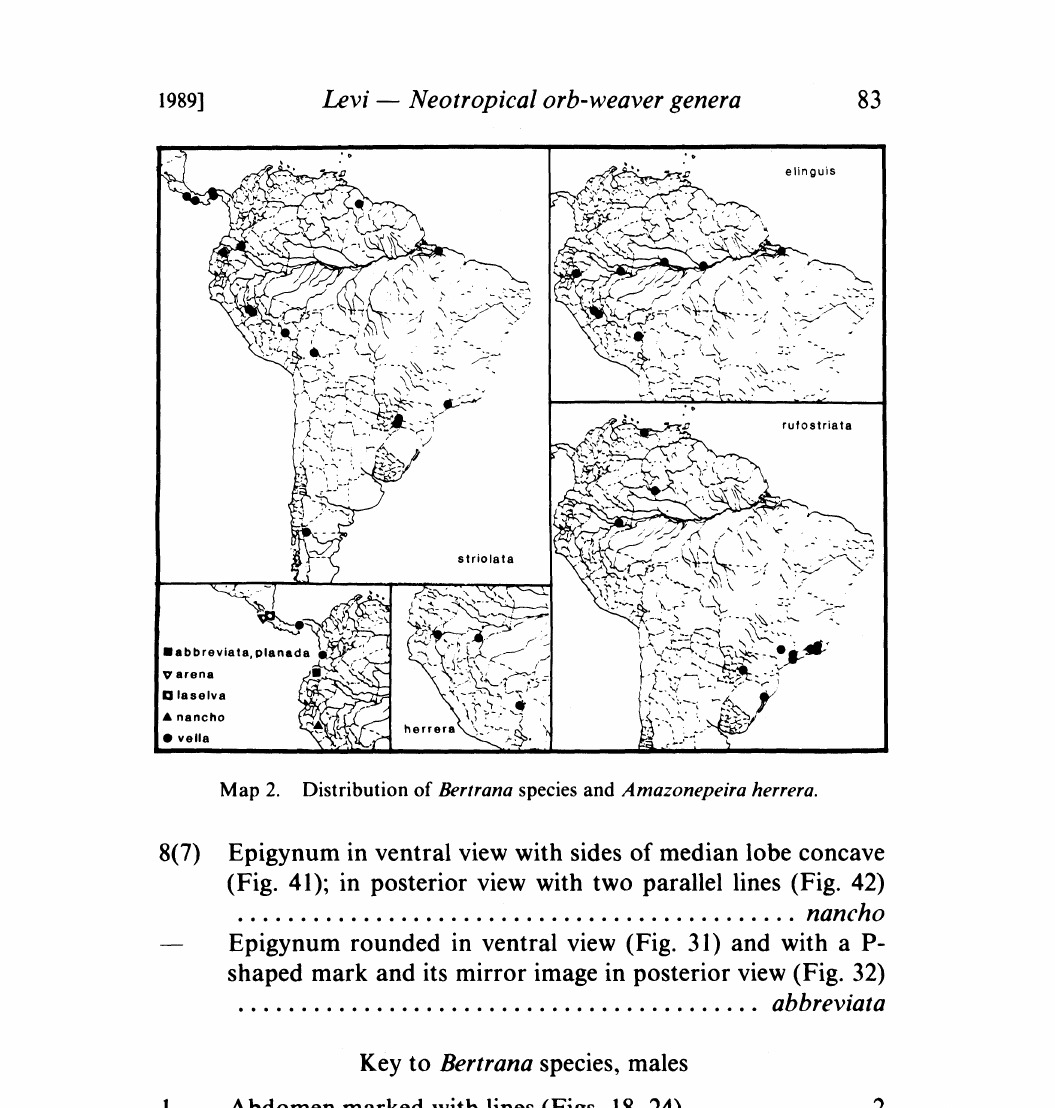
Map 2. Distribution of Bertrana species and Amazonepeira herrera. 8(7) Epigynum in ventral view with sides of median lobe concave (Fig. 41); in posterior view with two parallel lines (Fig. 42) nancho Epigynum rounded in ventral view (Fig. 31) and with a P- shaped mark and its mirror image in posterior view (Fig. 32) abbreviata Key to Bertrana species, males Abdomen marked with lines (Figs. 18, 24) 2 Abdomen otherwise 3 Median apophysis as wide as long; end of terminal apophysis expanded into a knob (Fig. 17) striolata Median apophysis much longer than wide; end of terminal apophysis pointed (Fig. 23)